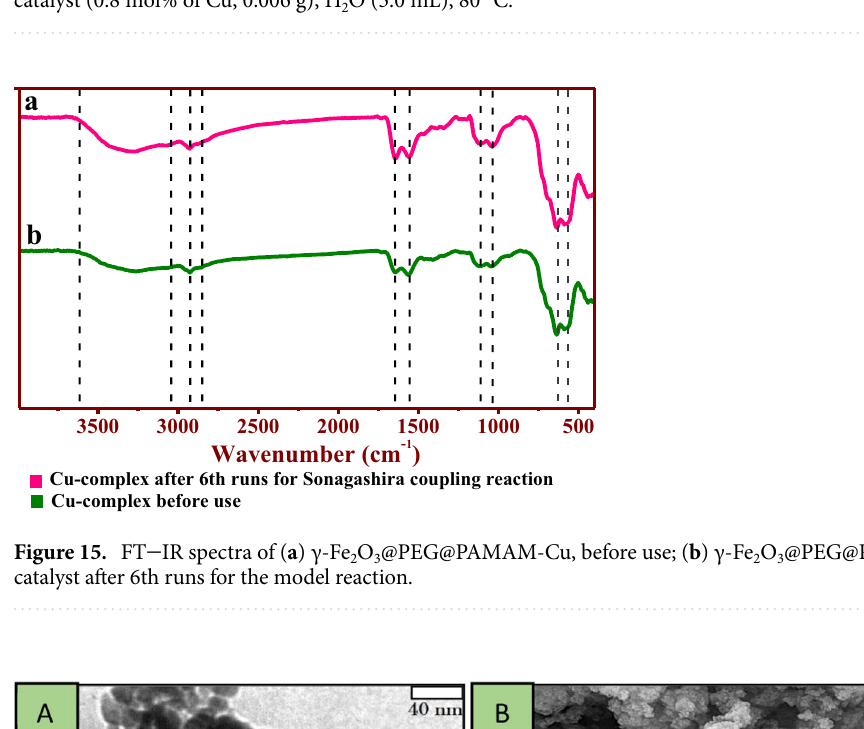
Table 3. Recyclability of the γ-Fe 2 O 3 @PEG@PAMAM G 0 -Cu catalyst in performed of the Sonogashira reaction a . a Reaction conditions: iodobenzene (1.00 mmol), phenylacetylene (1.5 mmol), NaOH (2.00 mmol),